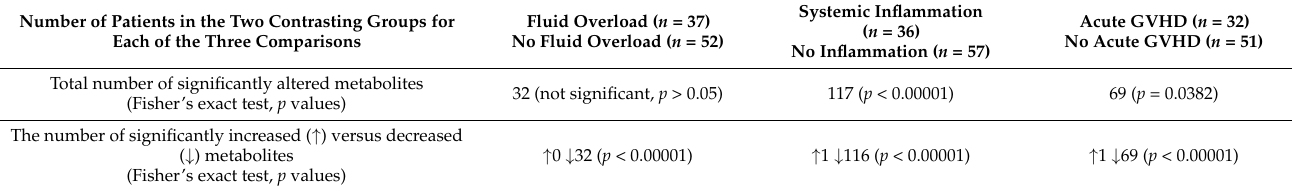
Table 2. The pretransplant systemic lipid profiles associated with posttransplant fluid overload, pretransplant systemic signs of inflammation (i.e., increased CRP levels) and posttransplant devel- opment of acute GVHD. For each of these three comparisons, the table presents (i) the number of patients with or without early fluid overload/pretransplant inflammation/acute GVHD (upper row) and (ii) the total number of lipid metabolites/biochemicals that differed significantly for each of the three comparisons (the middle row). The biochemicals that achieved statistical significance (i.e., p < 0.05) were identified by Welch’s two-sample t -test. We compared the total number of signifi- cantly altered metabolites for each of the three comparisons (fluid overload/inflammation/GVHD) with the corresponding expected number of differing metabolites that would be expected by co- incidence, i.e., statistical significance defined by a p value of 0.05 and corresponding to 5% of the 960 detected/analyzed metabolites (corresponding to 48 metabolites). The Fisher’s exact test was used for these analyses, and the corresponding p values are indicated in parentheses in the second row). We also compared the number of significantly increased versus decreased metabolites with the distribution that would be expected by coincidence, and the corresponding p values after using the Fisher’s exact test for these comparisons are indicated in the bottom